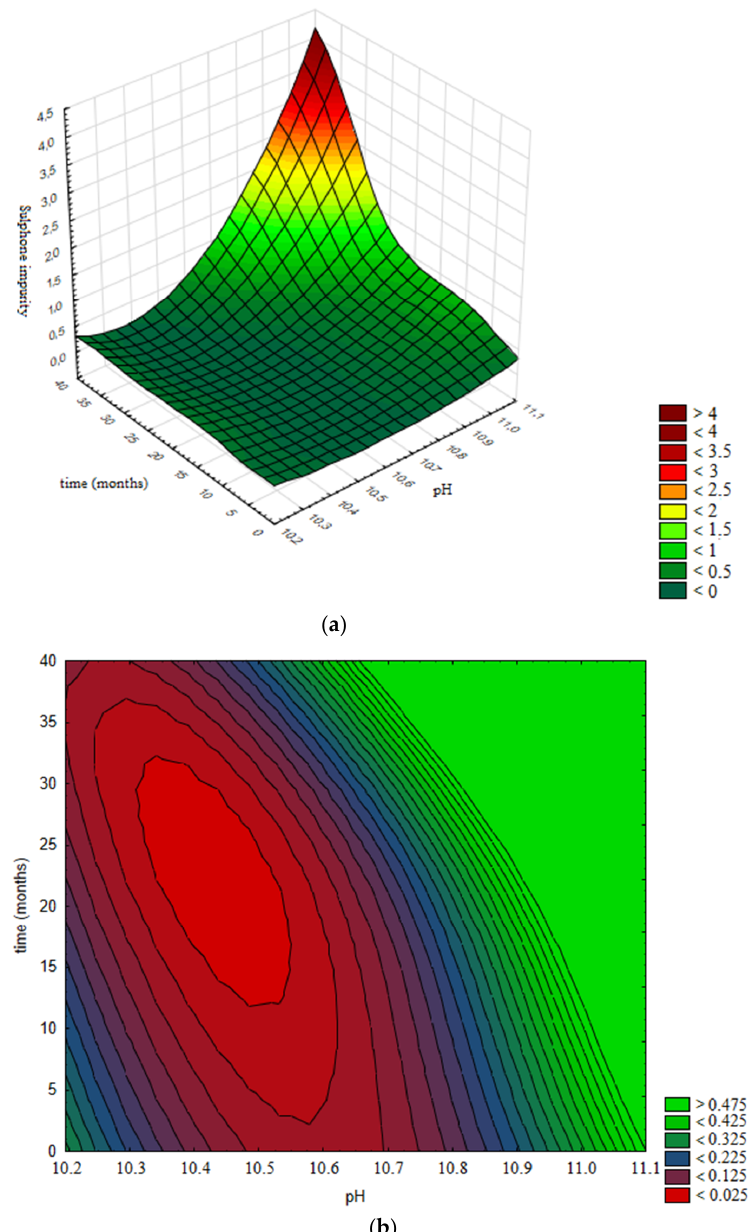
Figure 15. Influence of pH value and time on the assay of Sulphone impurity: ( a ) Response surface; ( b ) Contour plot.